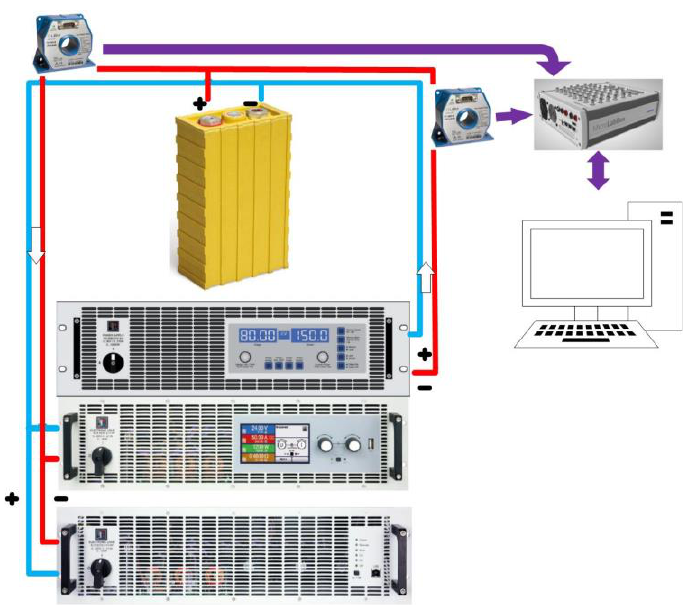
Figure 3. The hardware setup for HPPC.